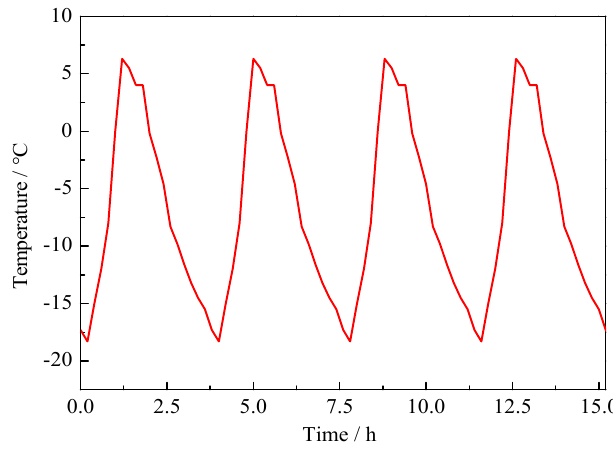
Figure 2. Temperature variation during F-T cycles.